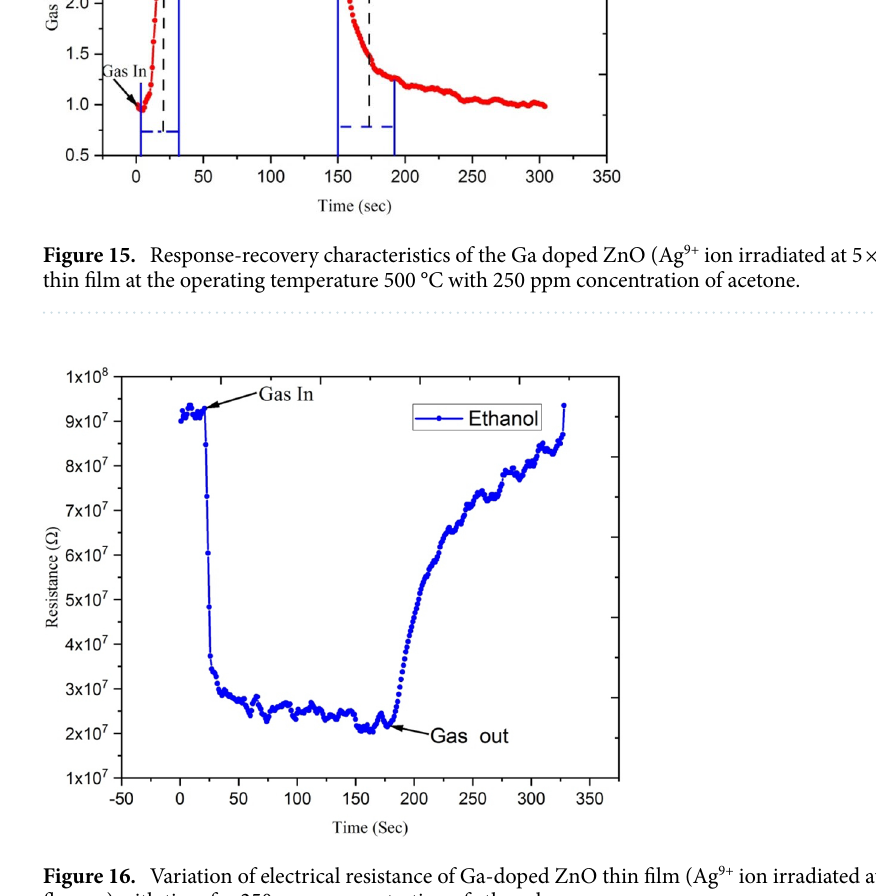
Figure 16. Variation of electrical resistance of Ga-doped ZnO thin film (Ag 9+ ion irradiated at 5 × 10 13 ion fluence) with time for 250 ppm concentration of ethanol